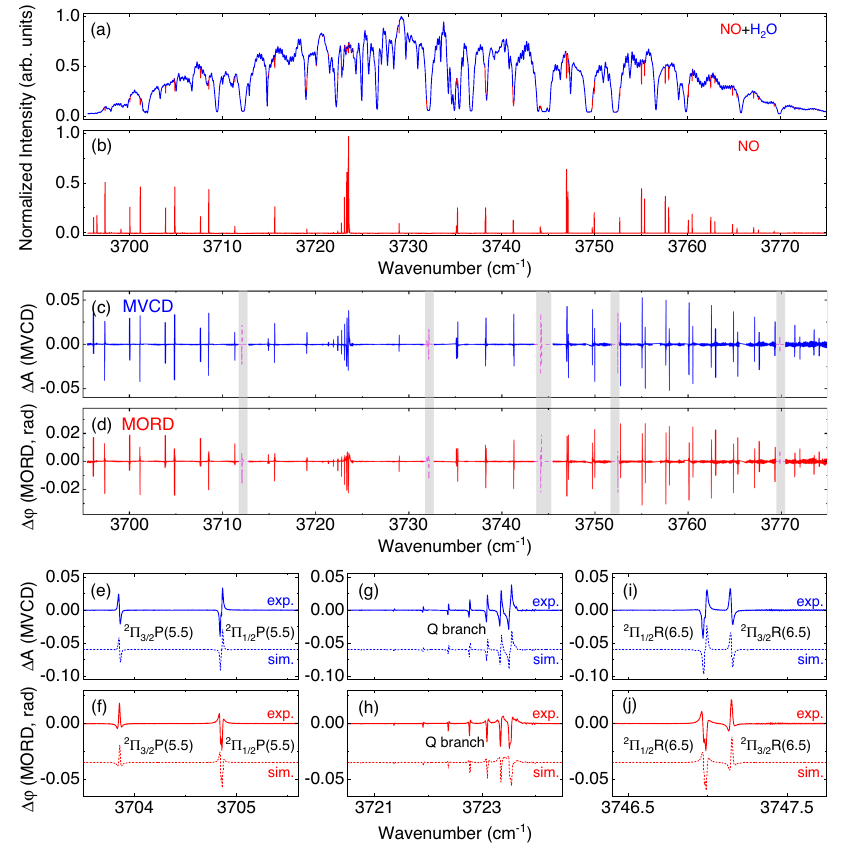
Fig. 5 | Measured magnetic vibrational optical activity signals of nitric oxide with DC-OAS in atmospheric environment. a , b Comparison of the absorption spectrum and MOA intensity spectrum of nitric oxide. The dips with red curves represent the absorption lines of NO. c , d MVCD and MORD spectra measured by DC-OAS.GrayshadedarearepresentsthefrequencyareamaskedbyH 2 Osaturated